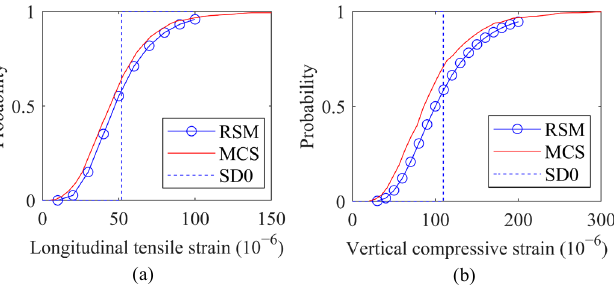
Figure 5. Results of the cumulative probability distributions of ( a ) longitudinal tensile strain at A1